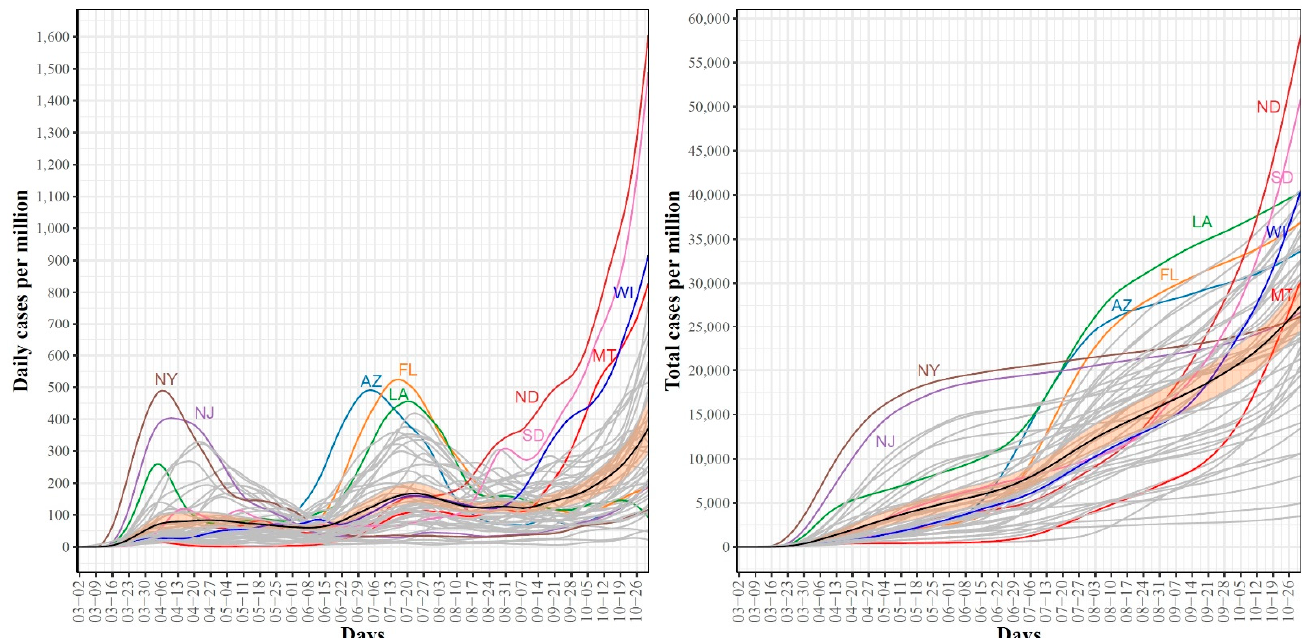
Figure 1. Trajectories for COVID-19 daily ( left ) and total ( right ) per million confirmed cases for the 51 US states. The mean curve is highlighted in black and the orange ribbon corresponds to the 95% confidence band.